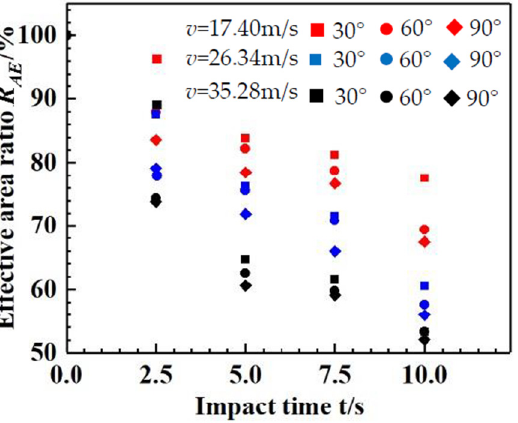
Figure 10. Relationship between the effective area ratio R AE of glass specimens and impact time t.